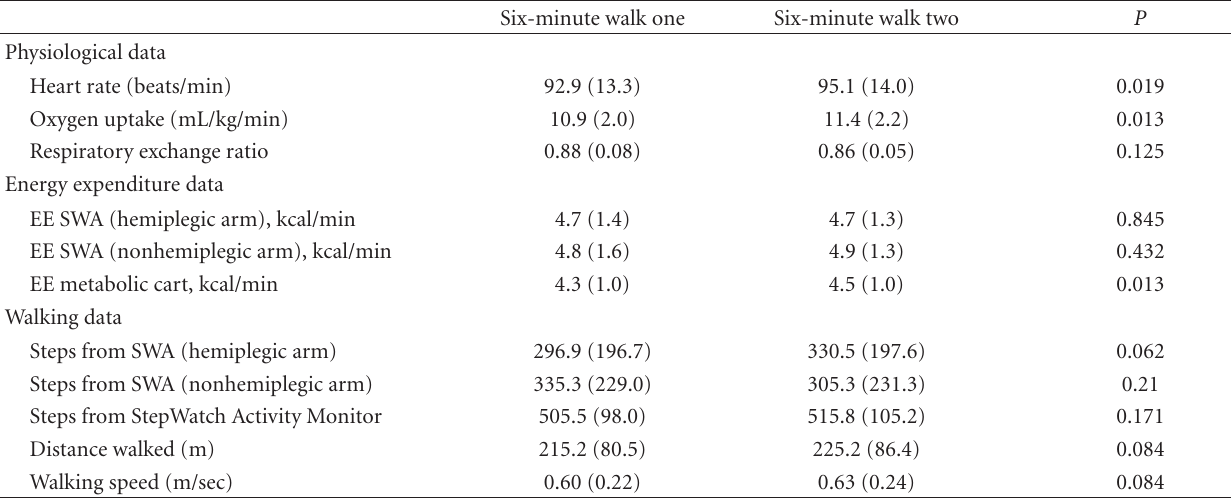
Table 2: Physiological, energy expenditure, and walking data from six-minute walks.